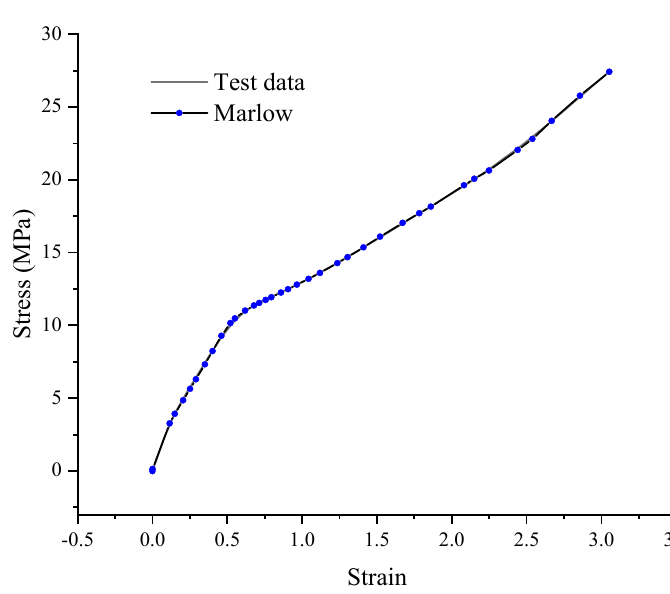
Figure 8. The fitting data of thermoplastic polyurethane (TPU) material with Marlow criterion. Also, we applied a general contact to the model and to ensure without initial